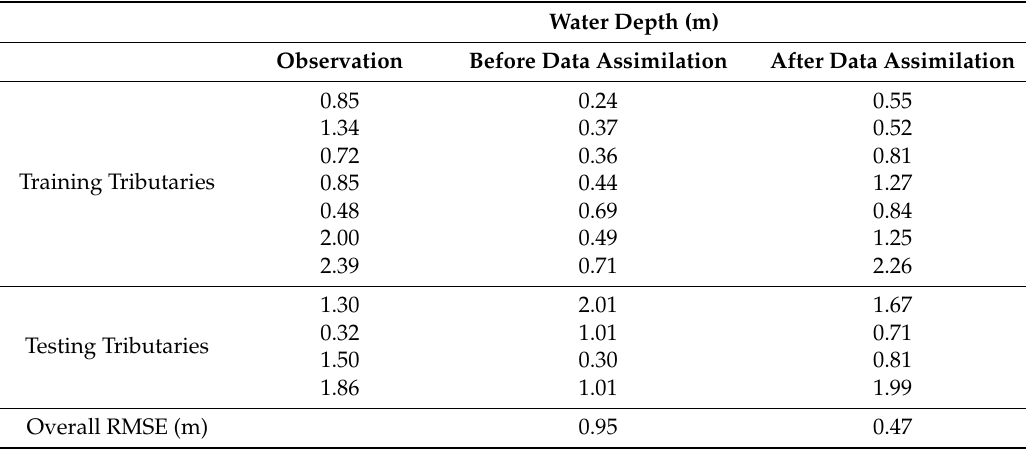
Table 2. Water depth before and after data assimilation compared with water depth measurement from the Iowa Flood Information System (IFIS) for training and testing tributaries.